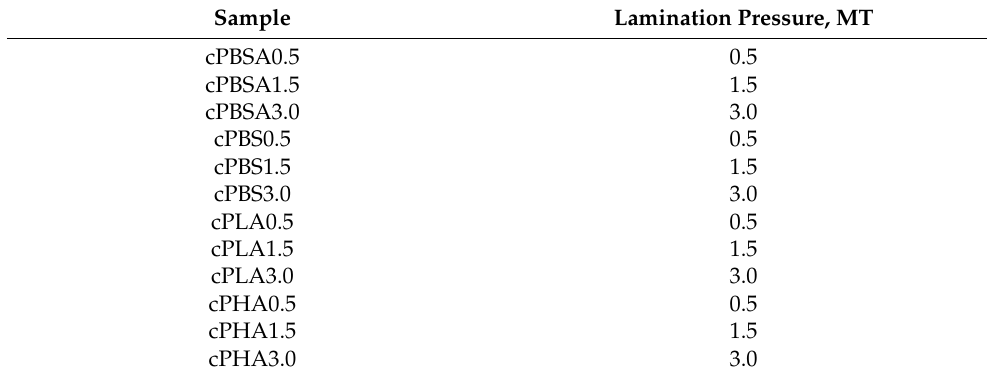
Table 1. The prepared